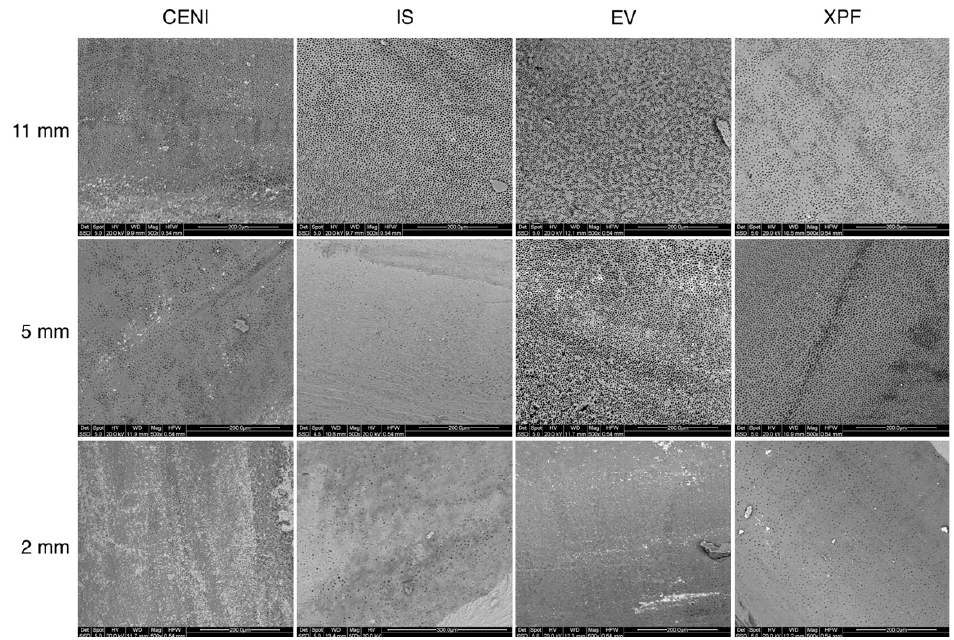
Figure 4. Representative SEM images of areas used for CH residues evaluation for each kind of treatment and root level from the apex.